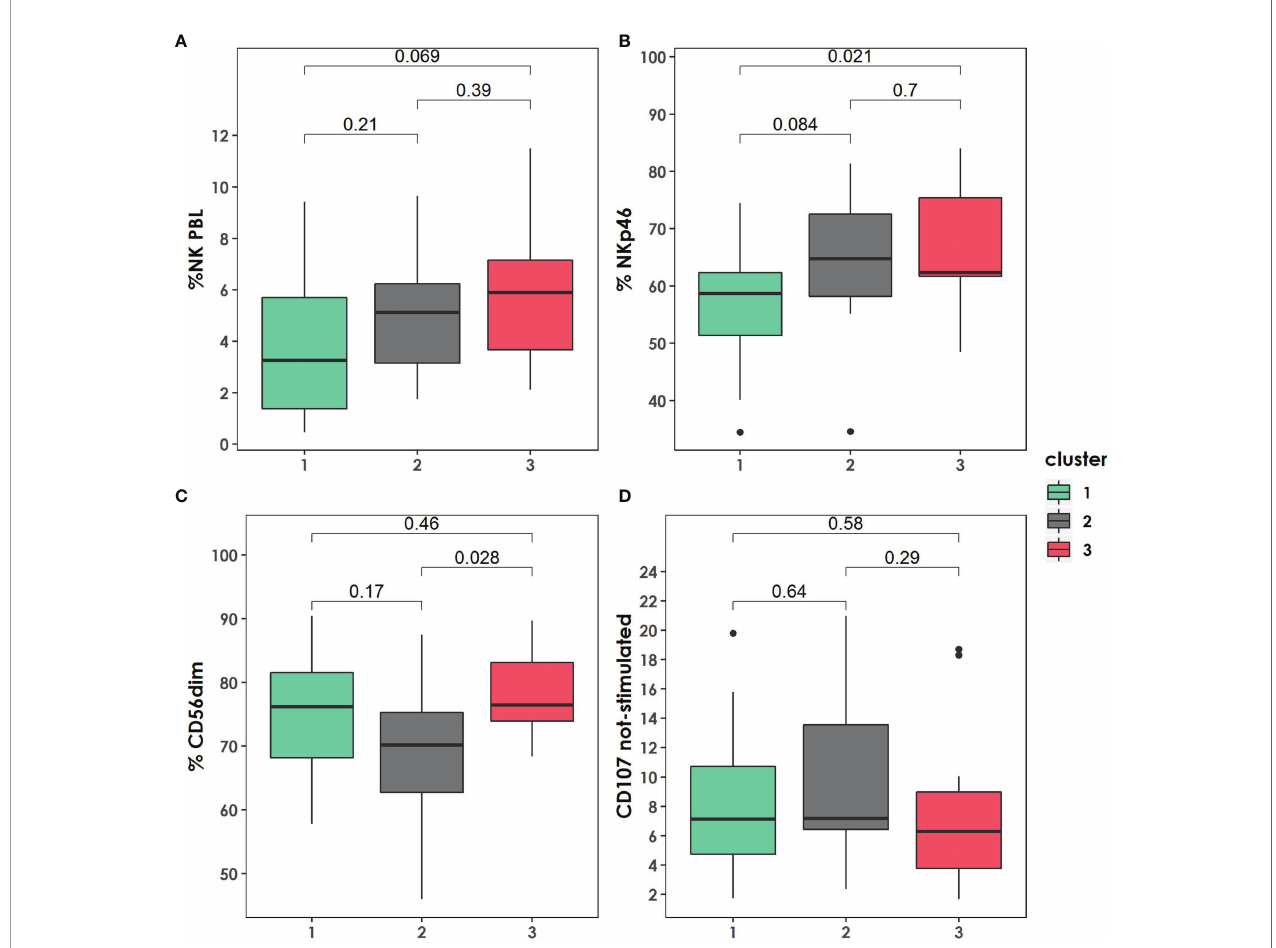
FIGURE 5 | Distribution of Natural Killer (NK) subpopulations within the clusters described. (A) Total percentage of NK on peripheral blood lymphocytes distribution among the clusters. (B) Percentage of NKp46 distribution among the clusters. (C) Percentage of CD56dim distribution among the clusters. (D) CD107 not- stimulated distribution among the clusters. P-values were calculated using U-Mann Whitney Test and Kruskal-Wallis test when